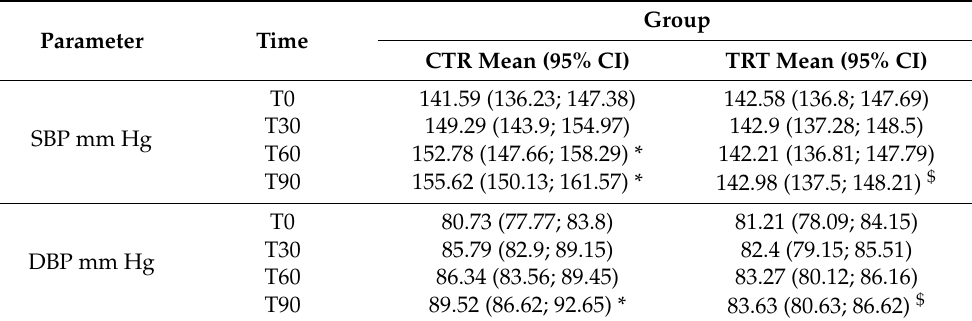
Table 3. Systolic (SBP, normal range < 150 mmHg) and diastolic (DBP, normal range < 95 mmHg) blood